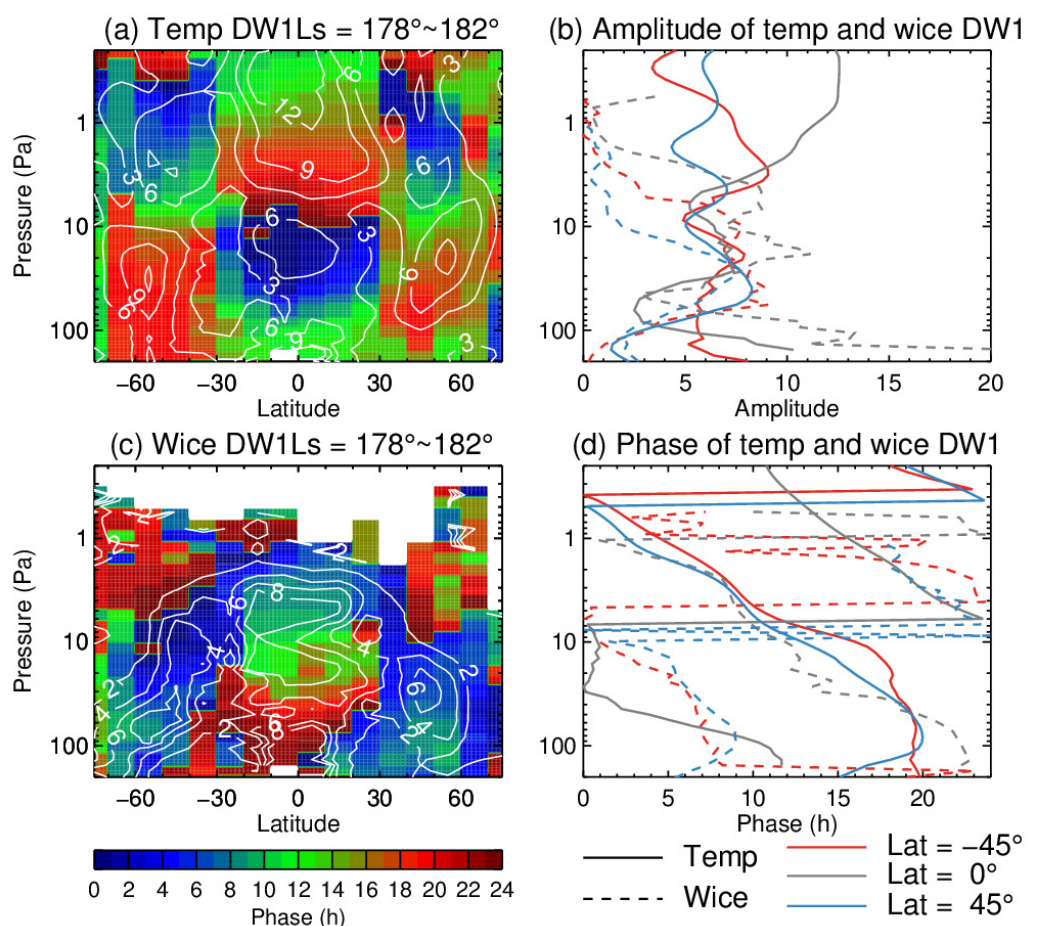
Figure 5. Latitude–altitude structures of ( a ) the temperature and ( c ) water ice DW1 amplitude (white contours) and phase (color shading) at the northern fall equinox. ( b , d ) The comparisons of their amplitude and phase, respectively, at the southern and northern middle latitudes and the equator region. The solid and dashed lines in ( b , d ) indicate the temperature and water ice DW1, respectively, while the colors represent different latitudes. Note that the water opacity value has been multiplied by 10 4 .